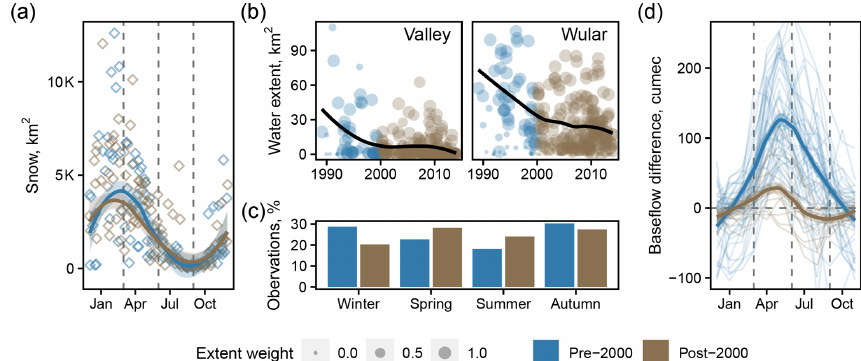
Figure 8. Declining water storage and baseflow. (a) Landsat observations of snow cover with loess smoothing, highlighting the earlier spring snowmelt after 2000. (b) Long-term trends in the valley inundation and Wular Lake, indicating decreasing surface water storage over time. The loess smoothing of the water extent is weighted by cloud cover given by exp ( − A cloud /A total ) . (c) The percent of satellite images used to assess water extent was seasonally consistent before and after 2000. (d) Baseflow at gauge iv (Sopore) minus baseflow at gauge iii (Asham), encompassing the river reach that includes Wular Lake. After 2000, baseflow peaks and depletes earlier in the year, as does a transition from gaining to losing